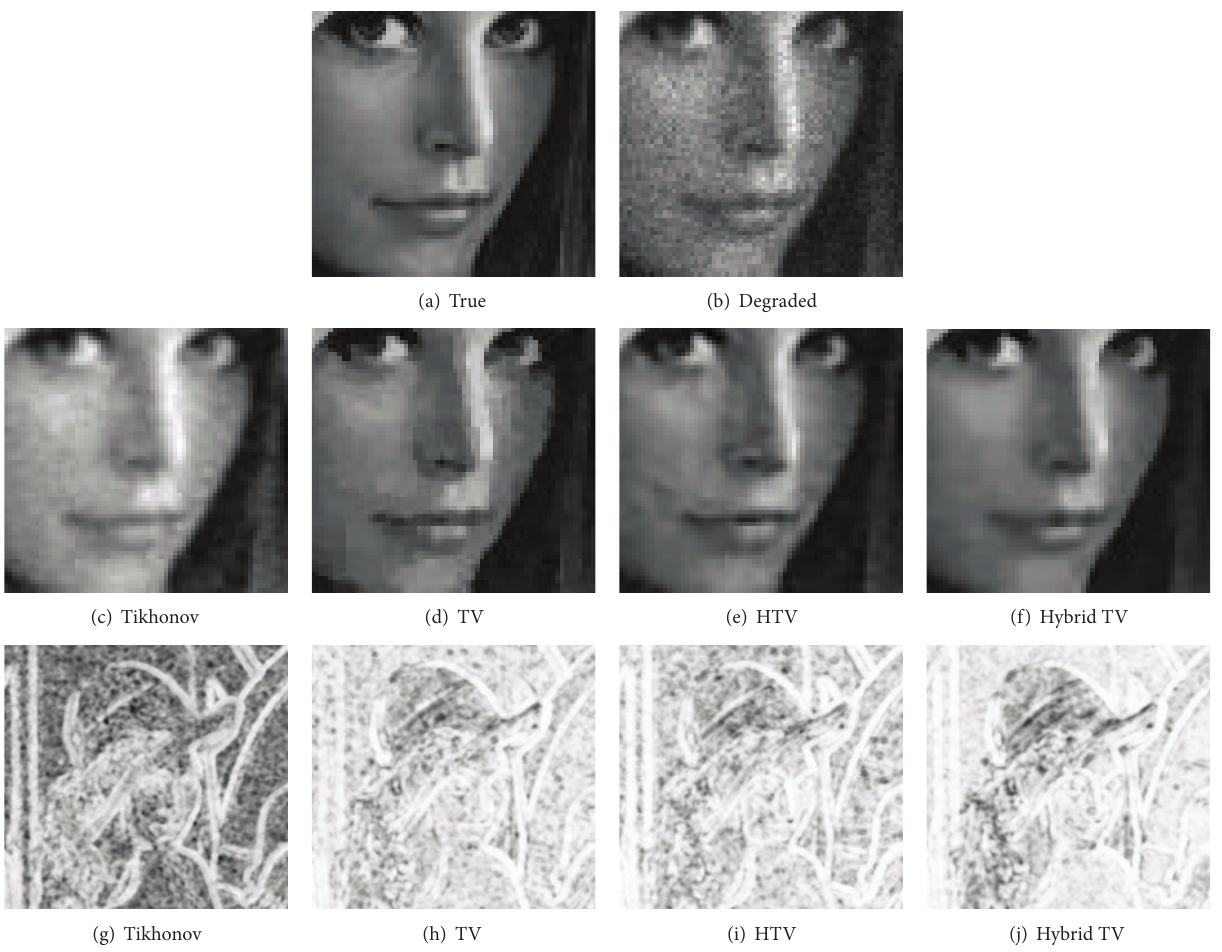
Figure 4: Comparison of a small portion of the restored images and SSIM maps for Example